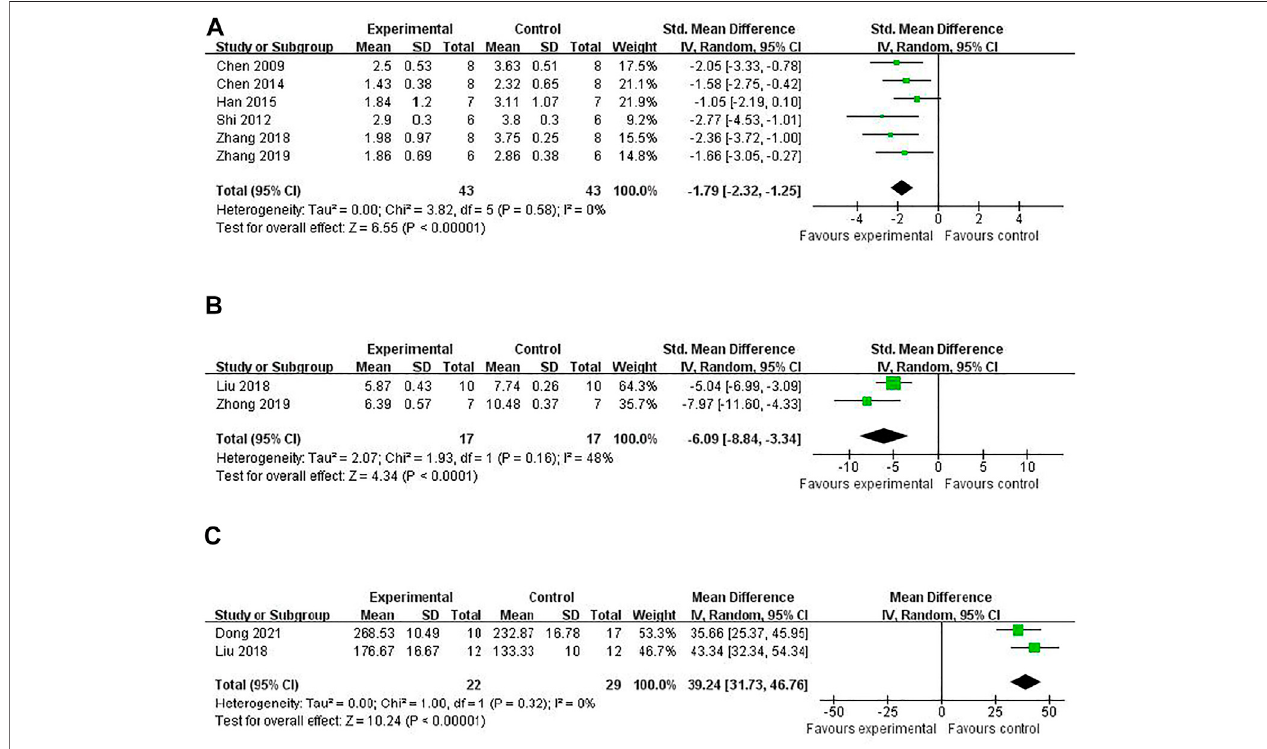
FIGURE 4 | The pooled estimate of RRC for improving neurological function score according to: (A) ZL score; (B) mNSS; (C) Rotarod tests.